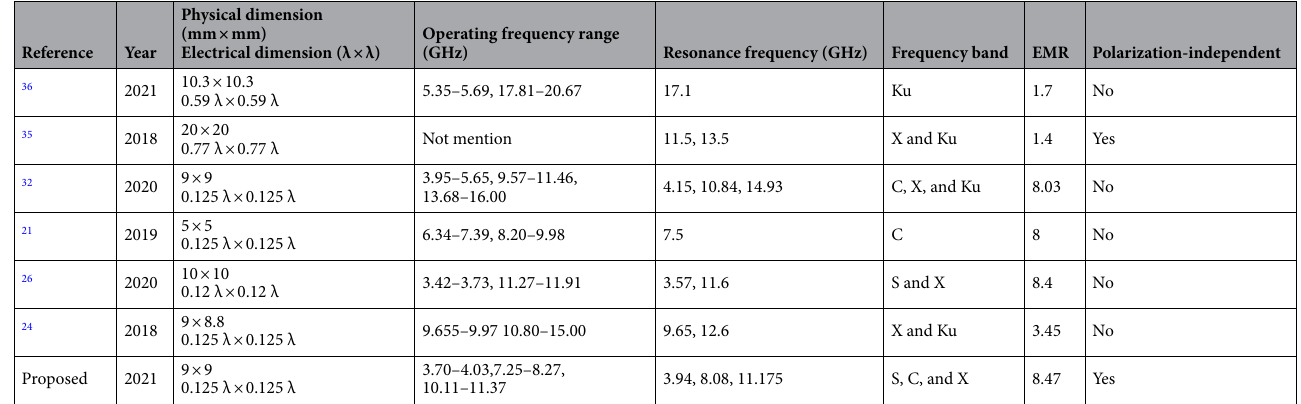
Table 4. Comparison between the existing work and proposed